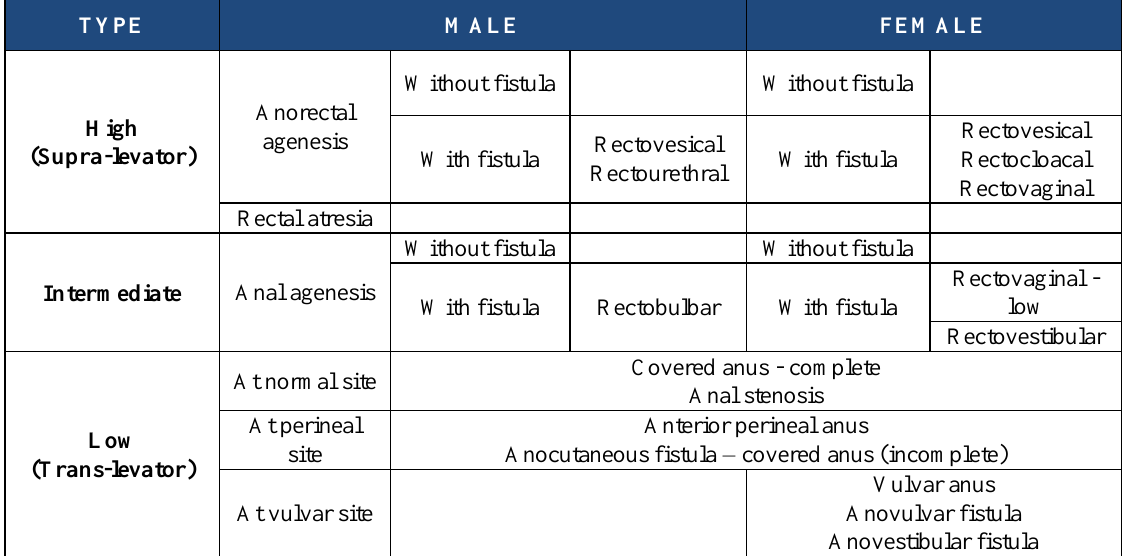
Table 1: International classification of Anorectal